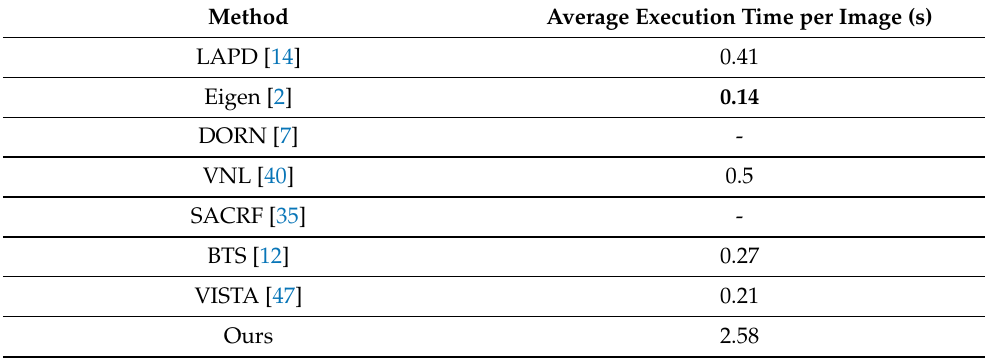
Table 6. A comparison of the execution times of the selected